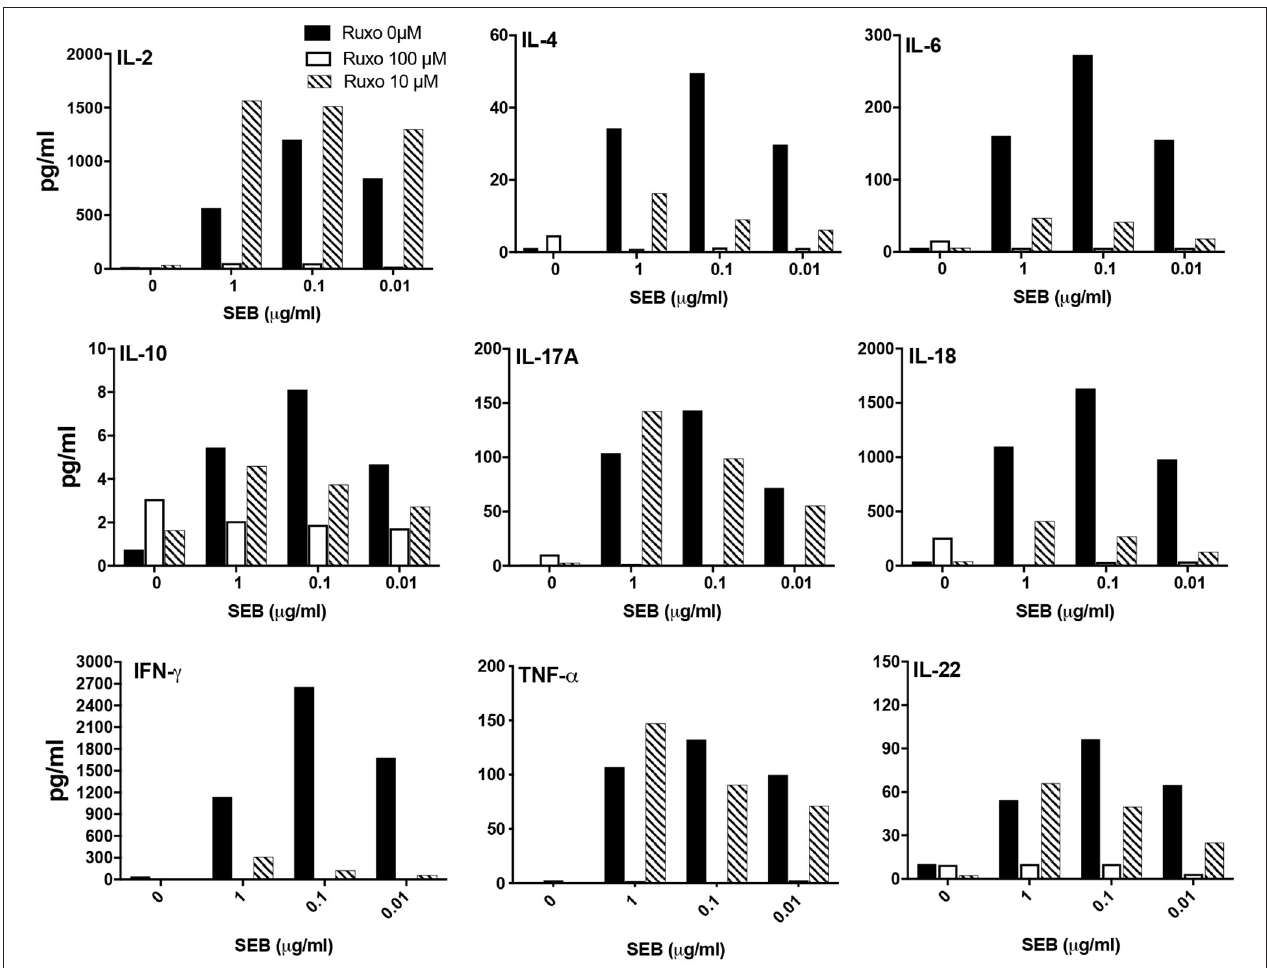
FIGURE 9 | Ruxolitinib inhibits SAg-induced cytokine production in vitro . Splenocytes from HLA-DR3 transgenic mice were cultured with medium alone or with indicated concentrations of SEB in the presence of ruxolitinib or vehicle for 48h. After the incubation period, the supernatants were harvested and the concentrations of indicated cytokines were determined using a multiplex assay as described in methods. Similar results were obtained from 3 independent experiments. Representative bar graphs from one experiment are